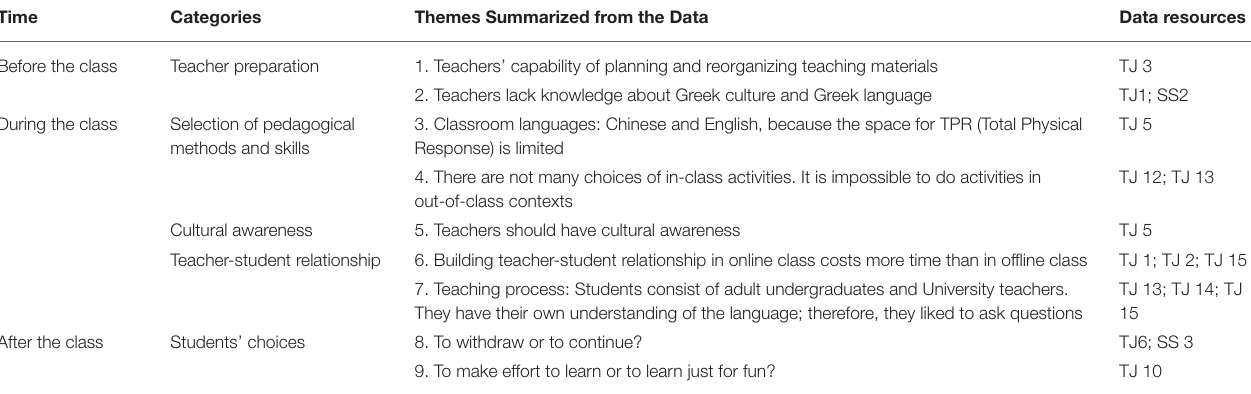
TABLE 2 | Challenges in